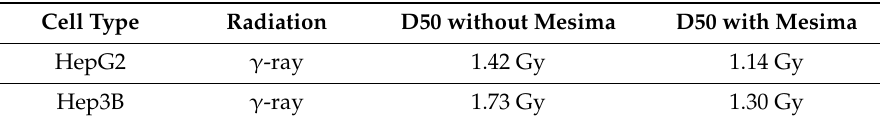
Table 2. Radiation dose needed to kill 50% of cells (D50) in the presence or absence of mesima. Values were obtained from Figure 1a.